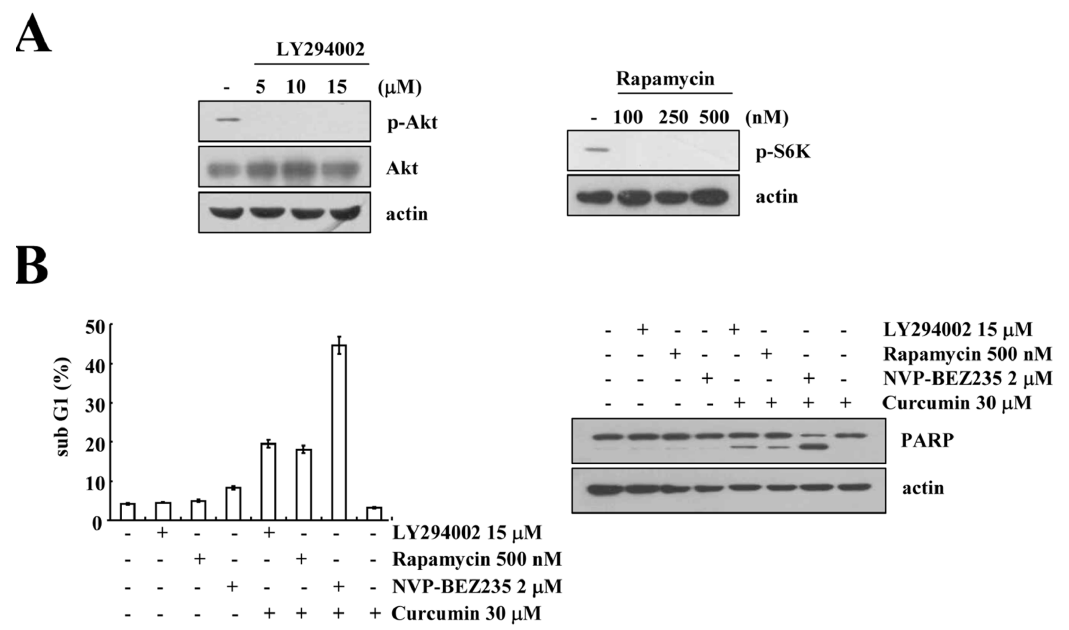
Figure 7. Effect of rapamycin, LY294002, and NVP-BEZ235 on apoptosis in curcumin-treated cells. (A) Caki cells were treated with the indicated concentrations of LY294002 (left panel) and rapamycin (right panel) for 6 h. Equal amounts of cell lysate (40 m g) were subjected to electrophoresis and analyzed by western blotting for phospho (p)-Akt, Akt, and p-S6K, as well as actin as a control for protein loading. (B) Caki cells were treated with the indicated concentrations of LY294002, rapamycin, and NVP-BEZ235 in the absence or presence of 30 m M curcumin for 48 h. The sub-G1 fraction was measured by flow cytometry. Equal amounts of cell lysate (40 m g) were subjected to electrophoresis and analyzed by western blotting for PARP and actin as a control for protein loading. The values in (B) represent the mean 6 SD from three independent samples. The data represent three independent experiments. Figure S1 Synergistic effect of NVP-BEZ235 and curcu- min on apoptosis in MDA-MB231 and U87MG cells.